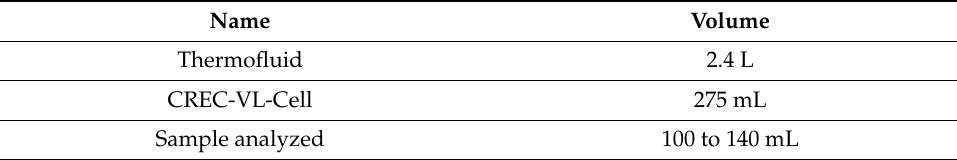
Table A1. CREC-VL-Cell Volumetric Capacity.